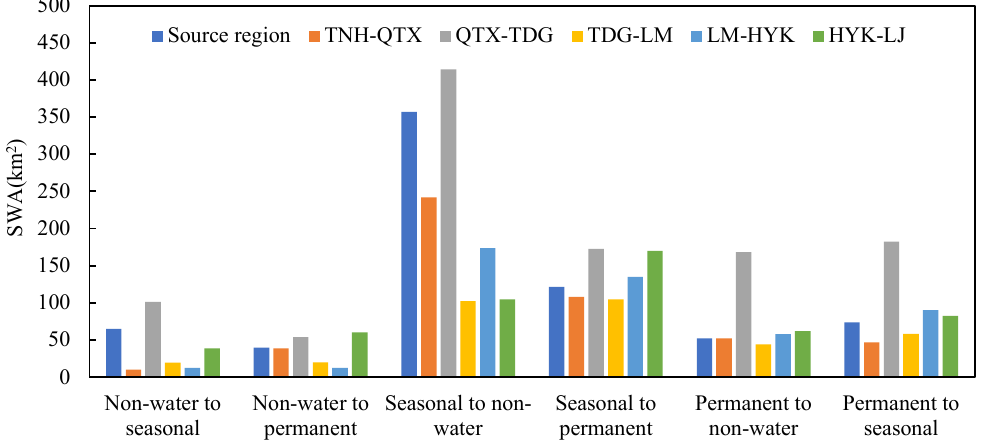
Figure 13. The SWA of the different surface water body conversion types from 1986 to 2019 in each sub-region in the YRB.